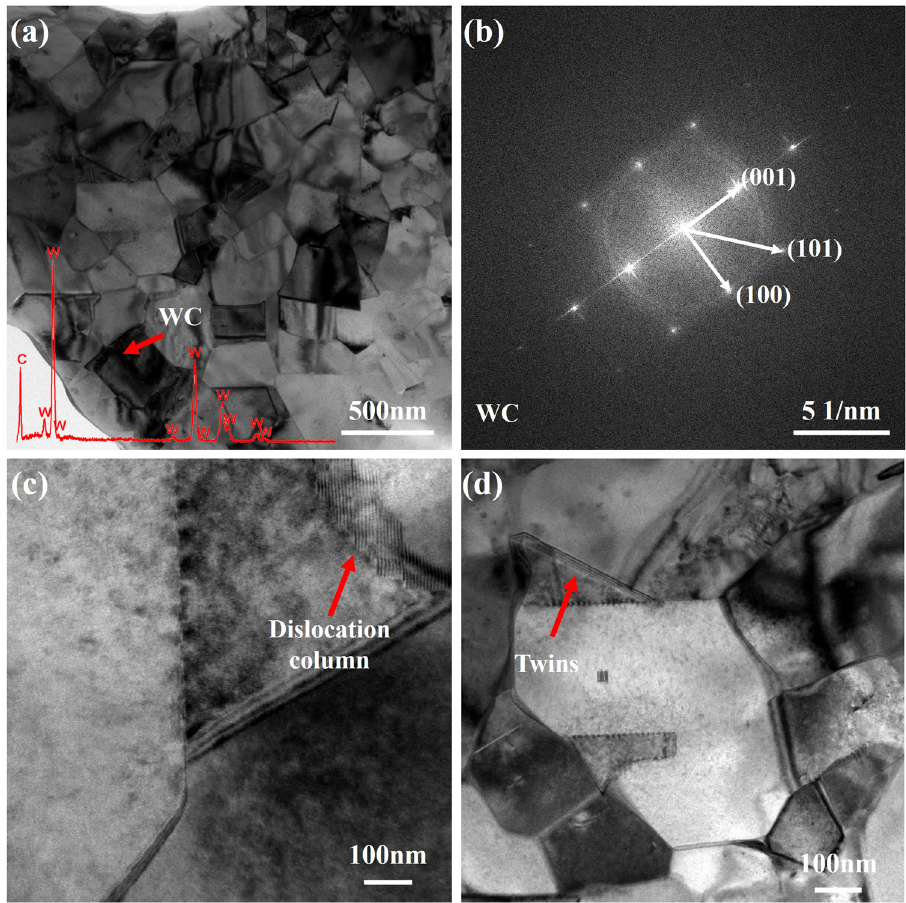
Figure 5: WC grain morphology and corresponding electron di ff raction pattern of WCN - 4# specimen and crystal defects of specimen: ( a ) WC grain morphology, ( b ) electron di ff raction pattern of WC grain, ( c ) dislocation column, and ( d )